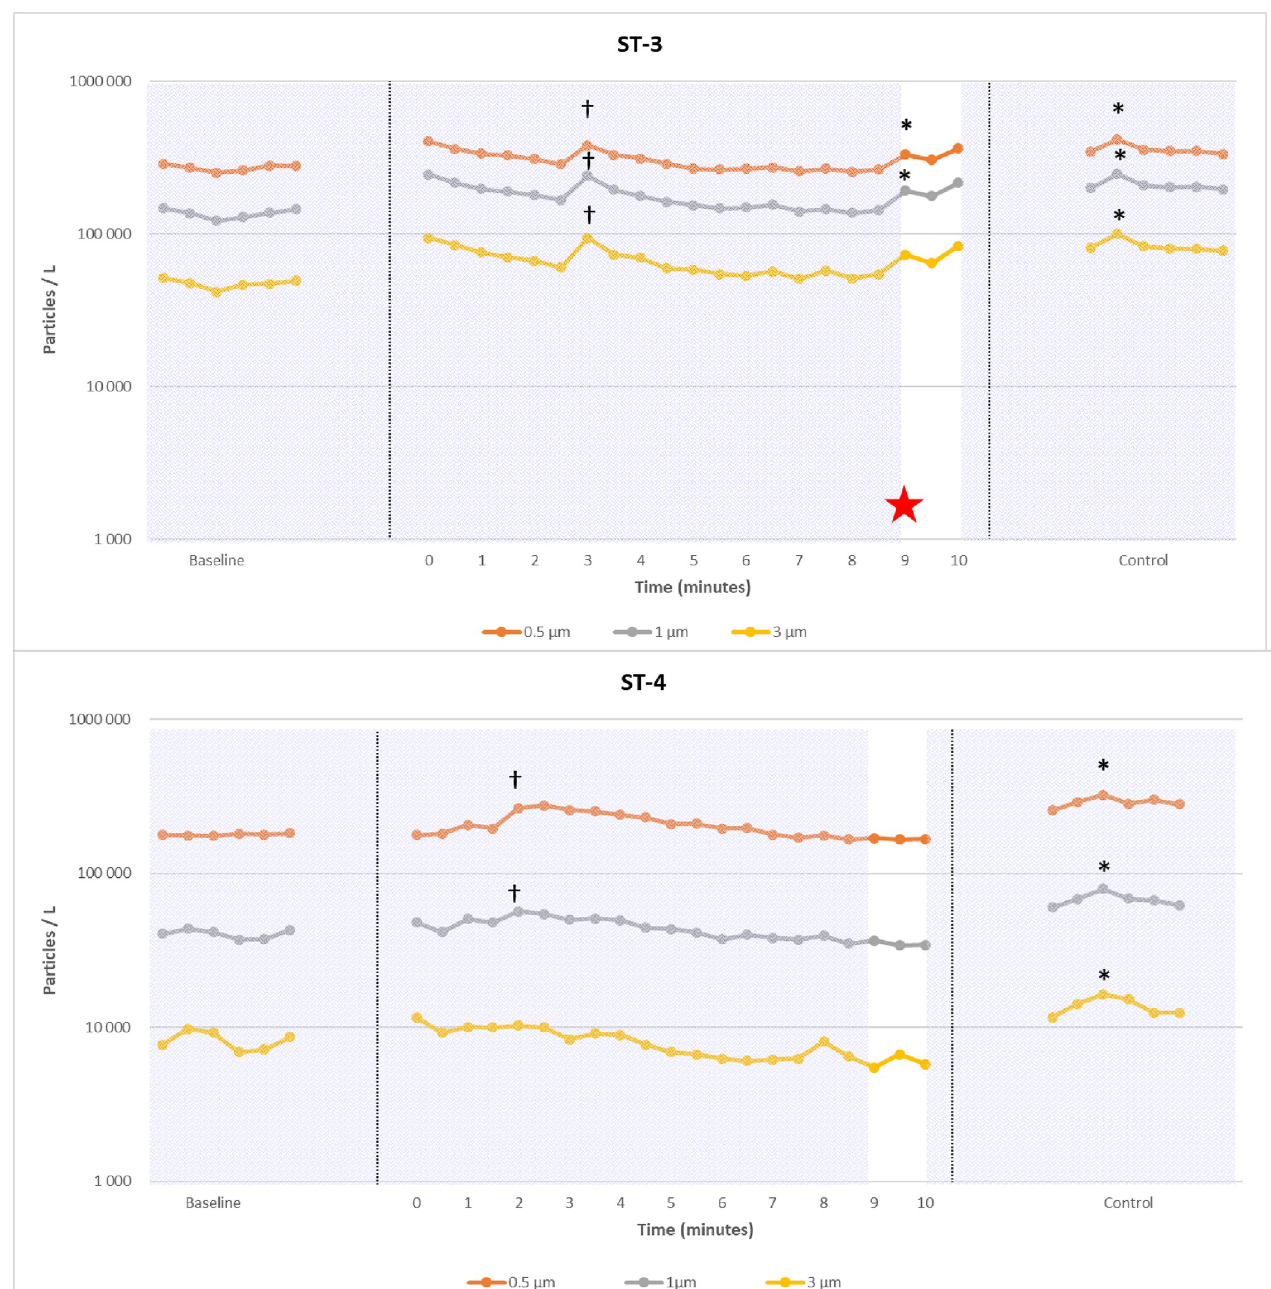
Fig 5. Examples of particle count (logarithmic scale) during two surgical tracheostomy procedures (ST). Hatching in the background: Intensive care ventilator on; white in the background: Intensive care ventilator off; � significant peaks related to a breach in ventilation circuit; † significant peaks related to an artifact (like dry gauze use); red star: Uneventful endotracheal tube cuff puncture. Baseline, procedure and intentional aerosol-generating maneuver (control) are shown. During ST-3, a late cuff puncture was responsible of 1 leak during the procedure, while no leaks occurred in ST-4.